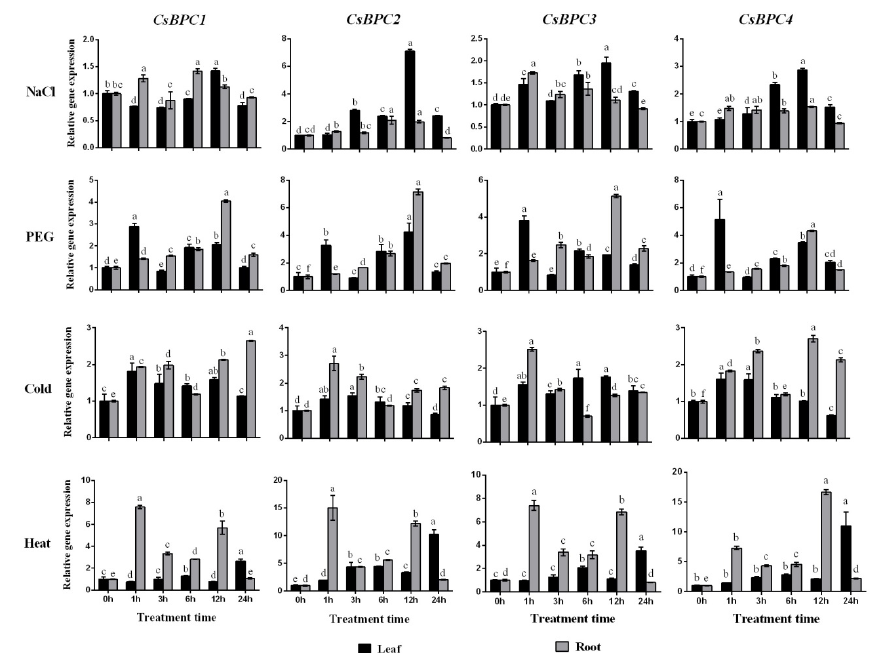
Figure 5. Expression patterns of CsBPC genes under different abiotic stress treatments. Cucumber seedlings at three-leaf-stage were exposed to 100 mM NaCl, 10% PEG 6000, cold (5 ◦ C), and heat (38 ◦ C) conditions, and qRT-PCR was performed to examine the transcript levels of CsBPCs in response to different abiotic stresses. The expression levels in non-stressed leaves and roots were set as 1. Values are means ± SD ( n = 3). Different letters indicate significant differences ( p < 0.05).